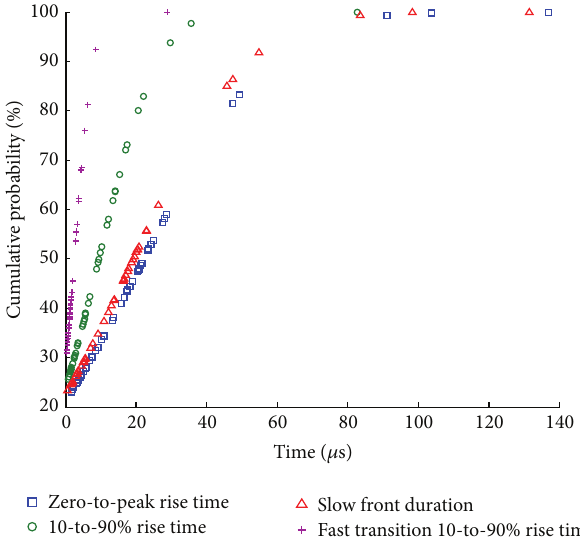
Figure 12: Cumulative probability distribution of various rise time parameters.